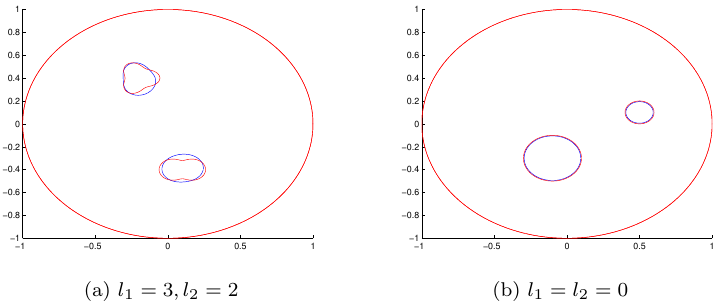
Figure 9. Apply TRA to reconstruct the shape of the coefficient with piecewise constant along with 1% noise data along with exact solution (red) and recovered solution (blue), respectively for Example